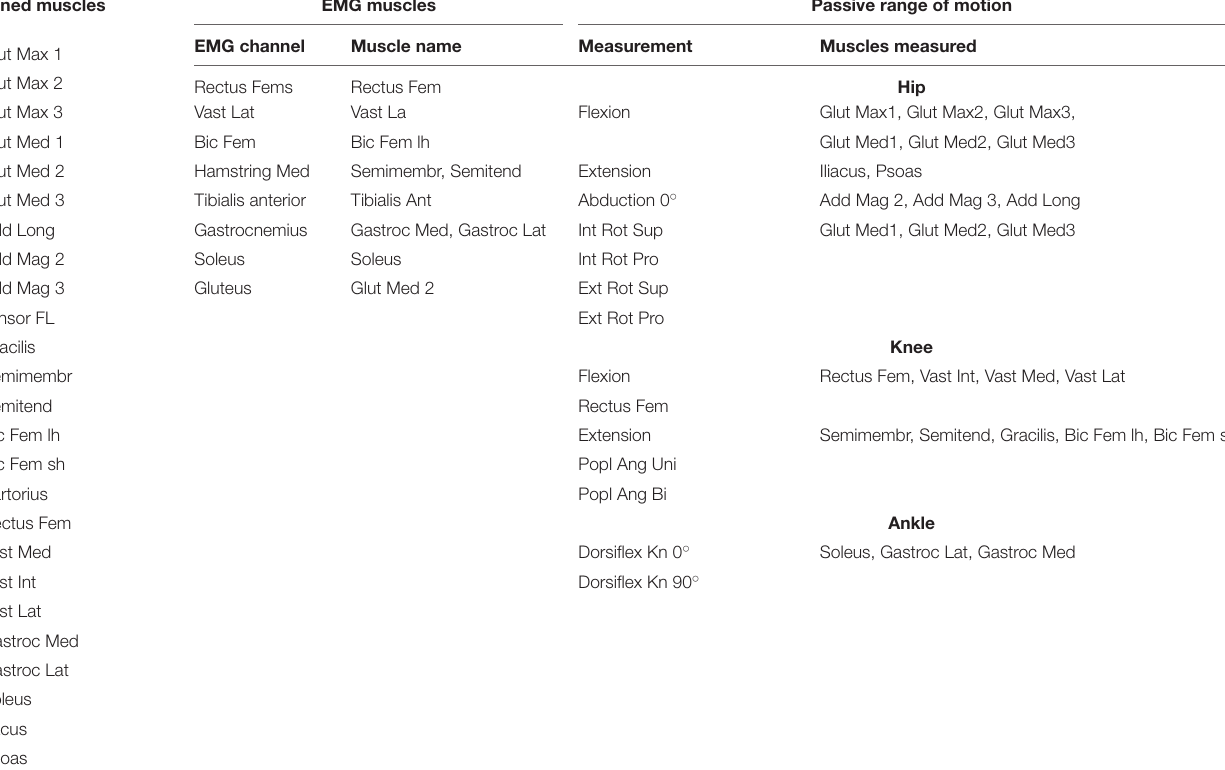
TABLE 2 | List of muscle